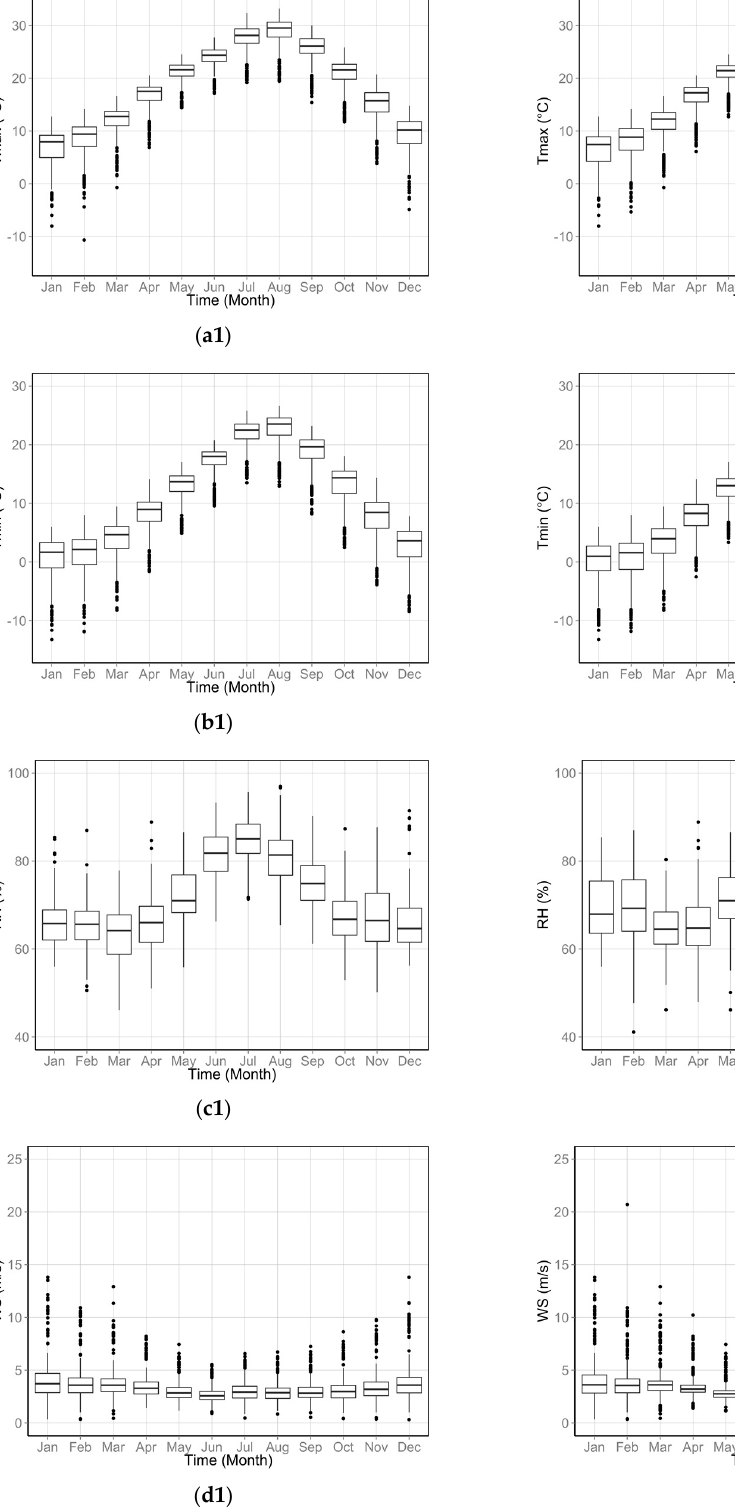
Figure 2. Monthly box plots of climate data for all stations from 1992 to 2013. ( a1 ) Observed monthly maximum temperature ( T max ) in °C; ( a2 ) Extended monthly T max in °C; ( b1 ) Observed monthly minimum temperature ( T min ) in °C; ( b2 ) Extended monthly T min in °C; ( c1 ) Observed monthly RH in %; ( c2 ) Extended monthly RH in %; ( d1 ) Observed monthly WS in m/s; ( d2 ) Extended monthly WS in m/s.